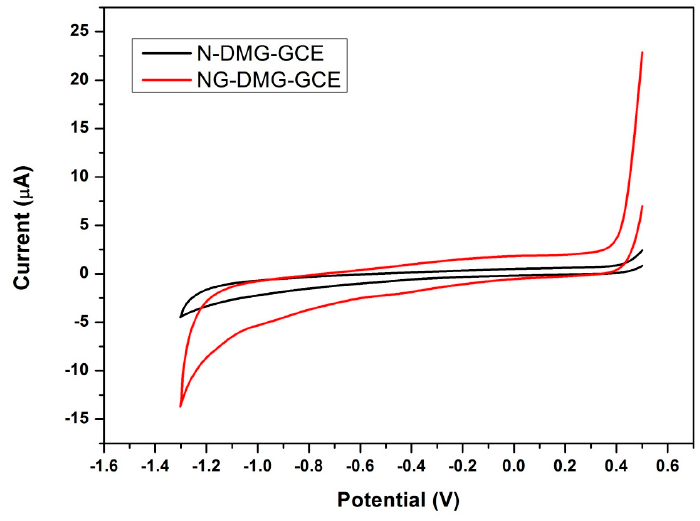
Figure 10. Cyclic voltammograms of N-DMG-GCE (black) and NGr-DMG-GCE (red). Supporting electrolyte 0.1 M NH 3 /NH 4 Cl Buffer (pH 9.3), scan rate (10 mV s − 1 ), deposition time (120 s), frequency (20 Hz), amplitude (0.02 V) and voltage step (0.005 V).